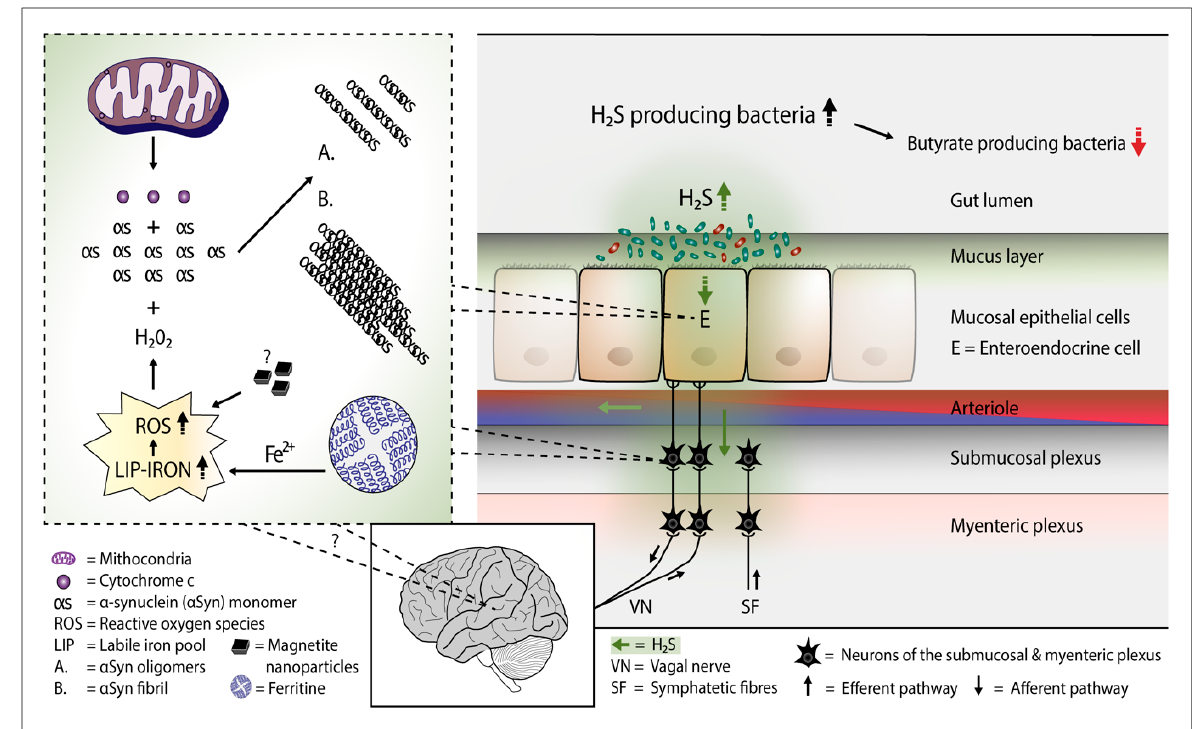
Figure 1. Plausible pathophysiological mechanism of Parkinson’s disease. Overgrowth of H 2 S producing gut bacteria raises H 2 S concentrations in the gut cells and blood. In the gut cells, excessively increased H 2 S releases Cyt c from the mitochondria and increases cytosolic iron (Fe 2+ ) levels. Consequently, the amount of reactive oxygen species (ROS) increases. The presence of magnetite nanoparticles originating from the Desulfovibrio species can further increase the emergence of ROS. The co-occurence of aSyn, Cyt c, and ROS (especially hydrogen peroxide) leads to aSyn aggregation. Emerged aSyn aggregates (oligomers and fibrils) may spread in a prion-like manner to the lower brain stem via the vagal nerve. In the blood H 2 S combines with hemoglobin. Part of H 2 S may remain in a free form and possibly induce aSyn aggregation even in the brain neurons.